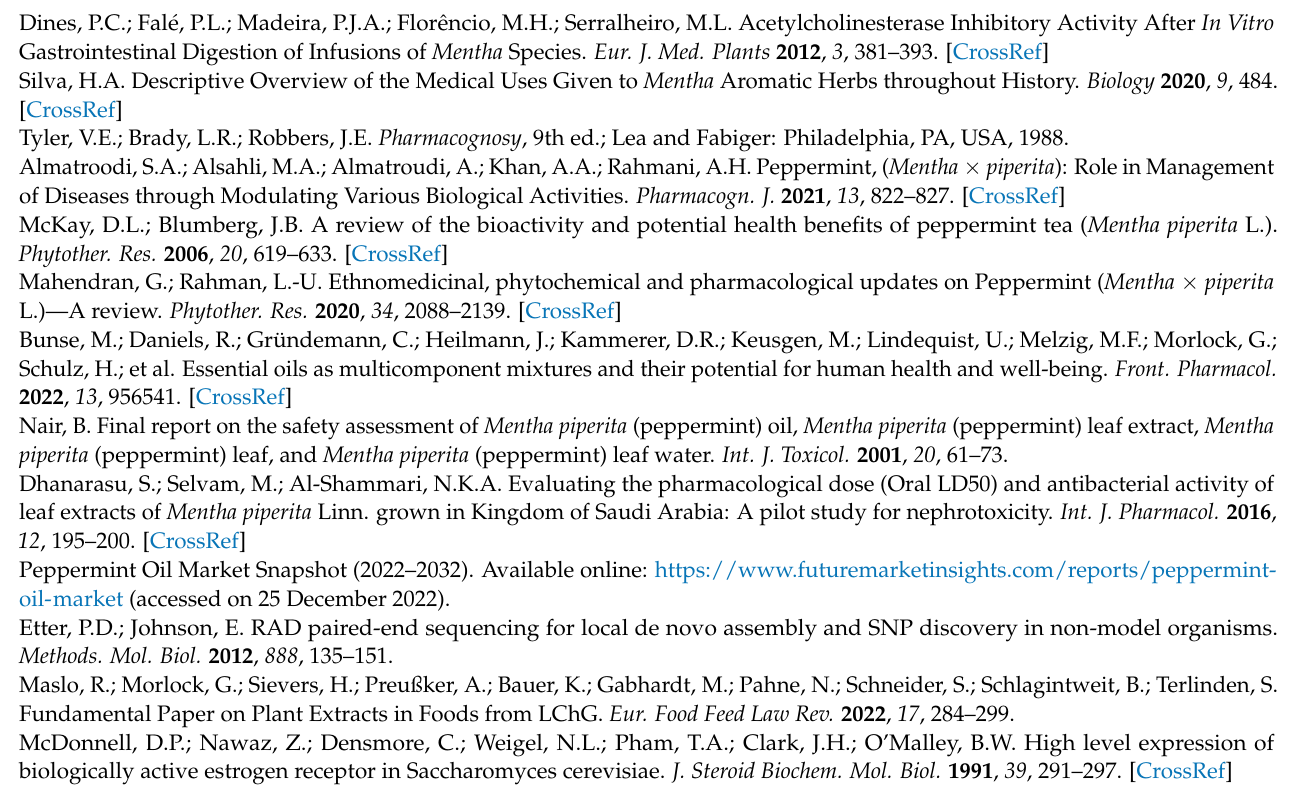
leaf sample L5; Figure S16: Headspace SPME–GC–FID profile of the European peppermint leaf sam- ple L2; Figure S17: Headspace SPME–GC–FID profile of the peppermint extract E2; Figure S18: Major volatile components of peppermint leaf sample L2 and the corresponding extract E2; Figure S19: Dose-response of the peppermint extract samples E1 − E7 on pathogen protection in the C. elegans model; Figure S20: Dose-response of the peppermint extract samples E1 − E7 on pathogen protection in the C. elegans model; Figure S21: Percentage of survival of C. elegans N2 treated with the different peppermint extracts E1 − E7; Figure S22: Phylogenetic relationships of the 24 peppermint varieties inferred using the maximum